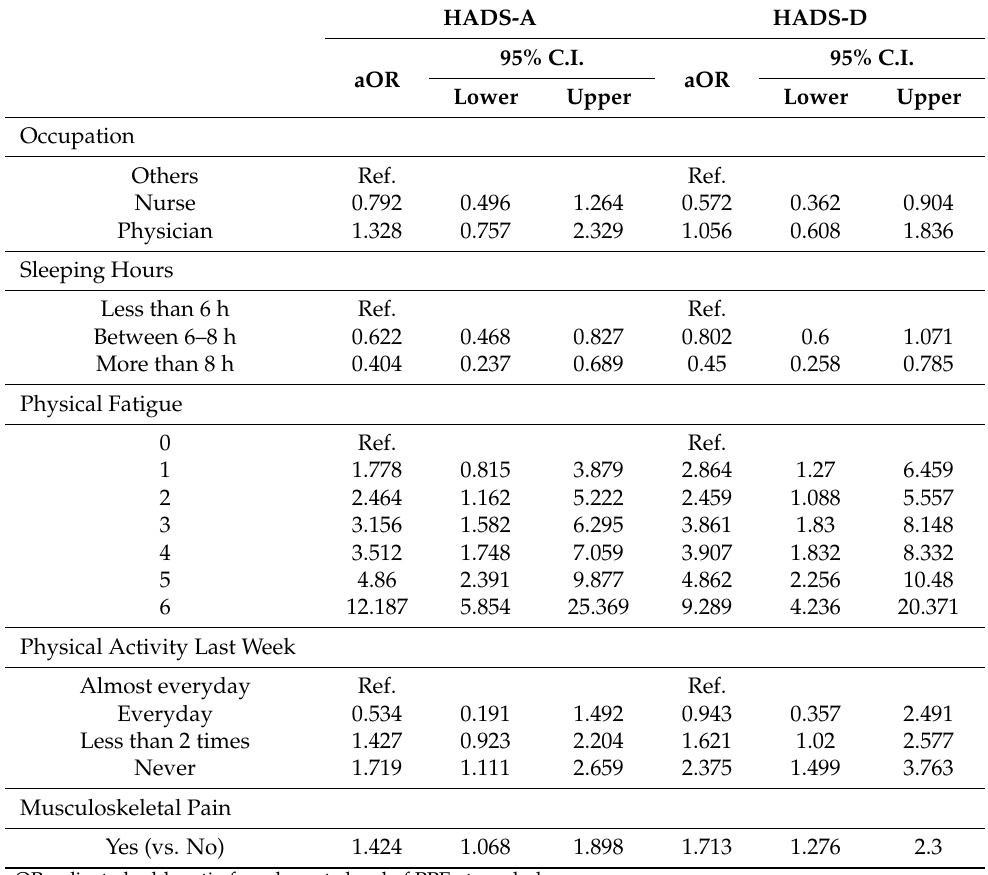
Table 3. Logistic regression models for the Hospital Anxiety and Depression Scale.